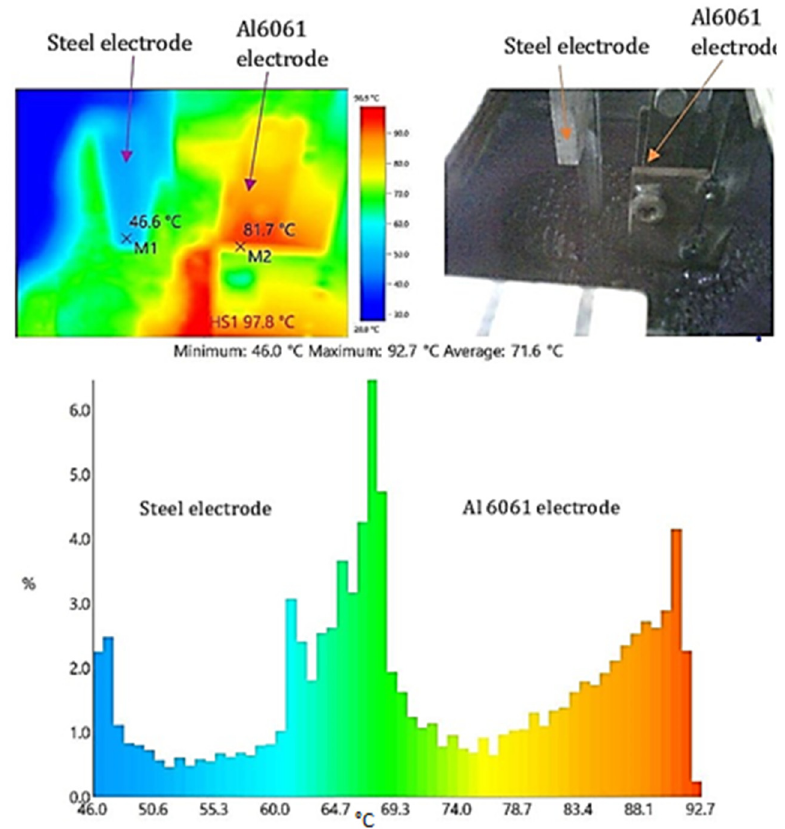
Figure 9. Temperature distribution between stainless steel electrode and Al 6061